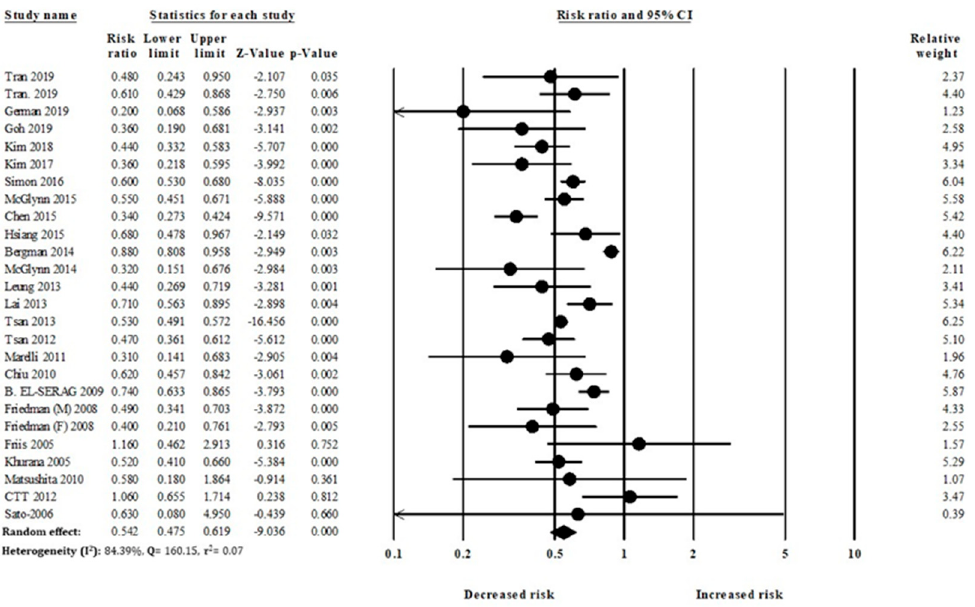
Figure 3. Statin use and hepatocellular carcinoma (HCC) risk .